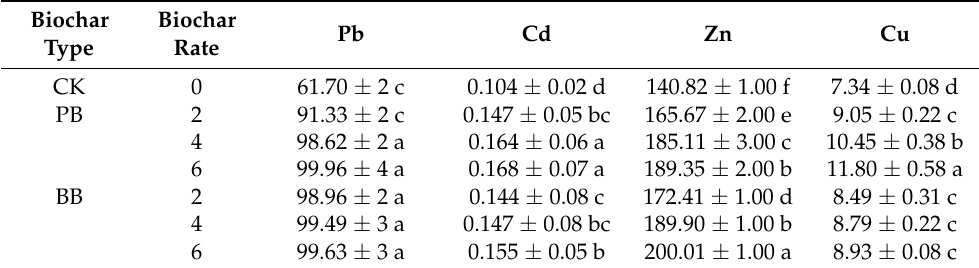
Table 6. Concentration of the soil heavy metal fraction bound to organic matter (mg kg − 1 ) determined with the BCR sequential extraction method.